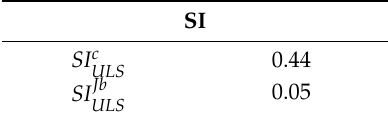
Table 1. Static performance of the considered frame.